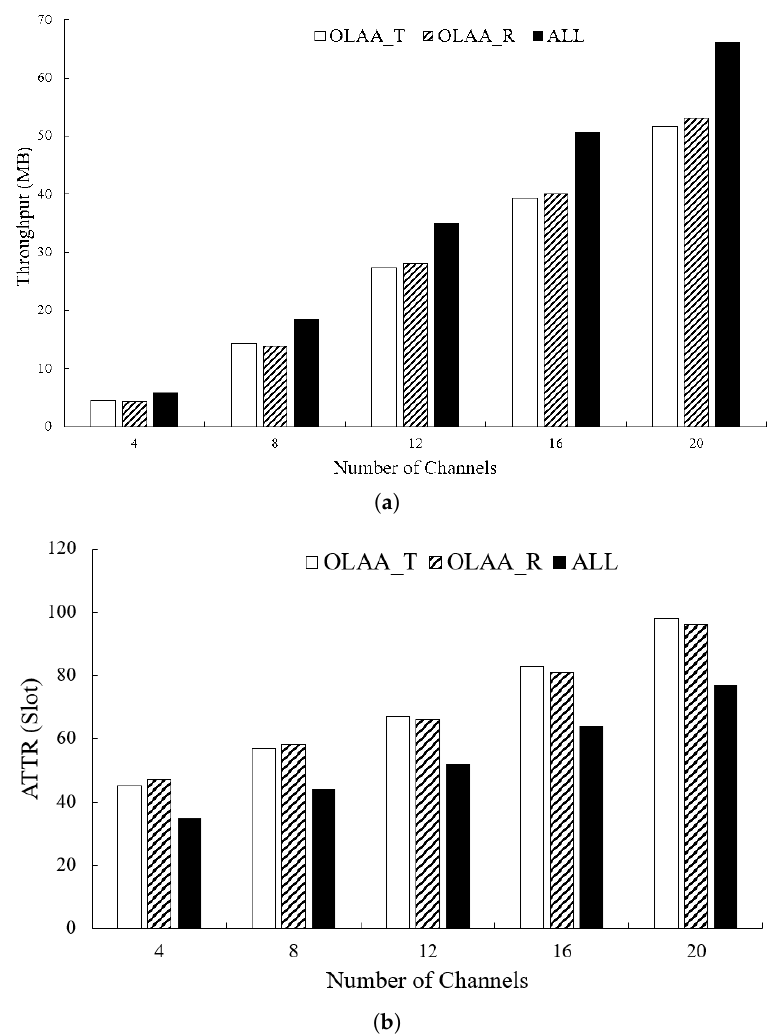
Figure 10. This figure displays the impact of the number of channels on the star topology’s perfor- mance in an asynchronous network, as measured by two metrics: ( a ) throughput and ( b )